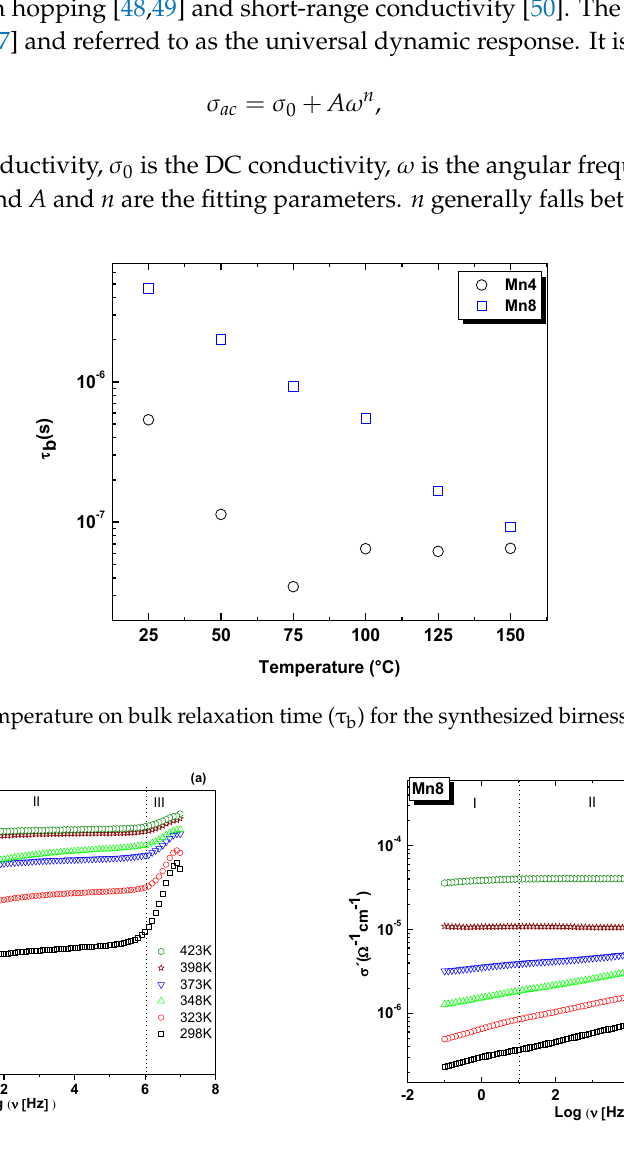
Figure 7. Real component of the complex conductivity as a function of temperature. ( a ) Mn4, birnessite type of material synthesized at 400°C, ( b ) Mn8, birnessite type of material synthesized at 400°C.